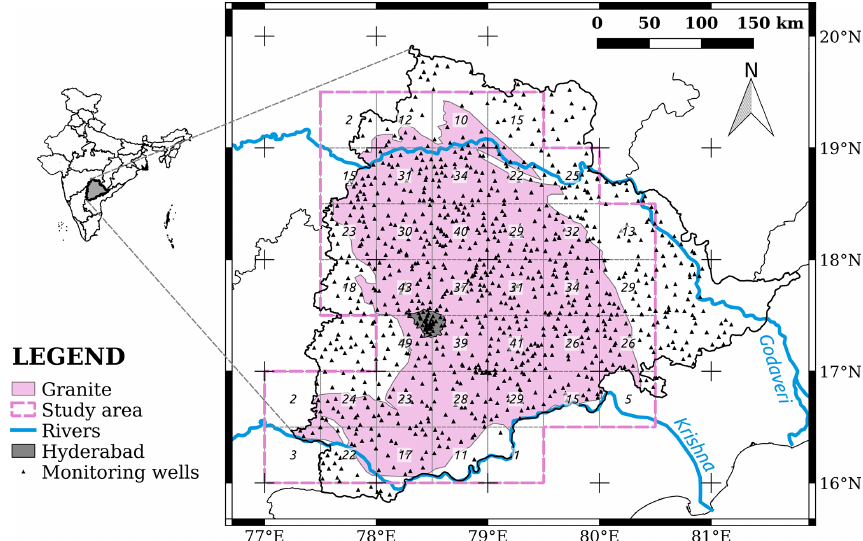
Figure 1. Location of the study area (dotted pink line, 113000km 2 ) that delineates the granitic area of Telangana (pink area, 67000km 2 , identified from Phani, 2014) with the target 0.5 ◦ resolution. The number of available observation wells (black triangles) monitored by the Groundwater Department of Telangana is indicated in the centre of each of the 38 0.5 ◦ pixels. The grey area indicates the extent of Hyderabad, the capital city of the state. The main rivers are indicated in